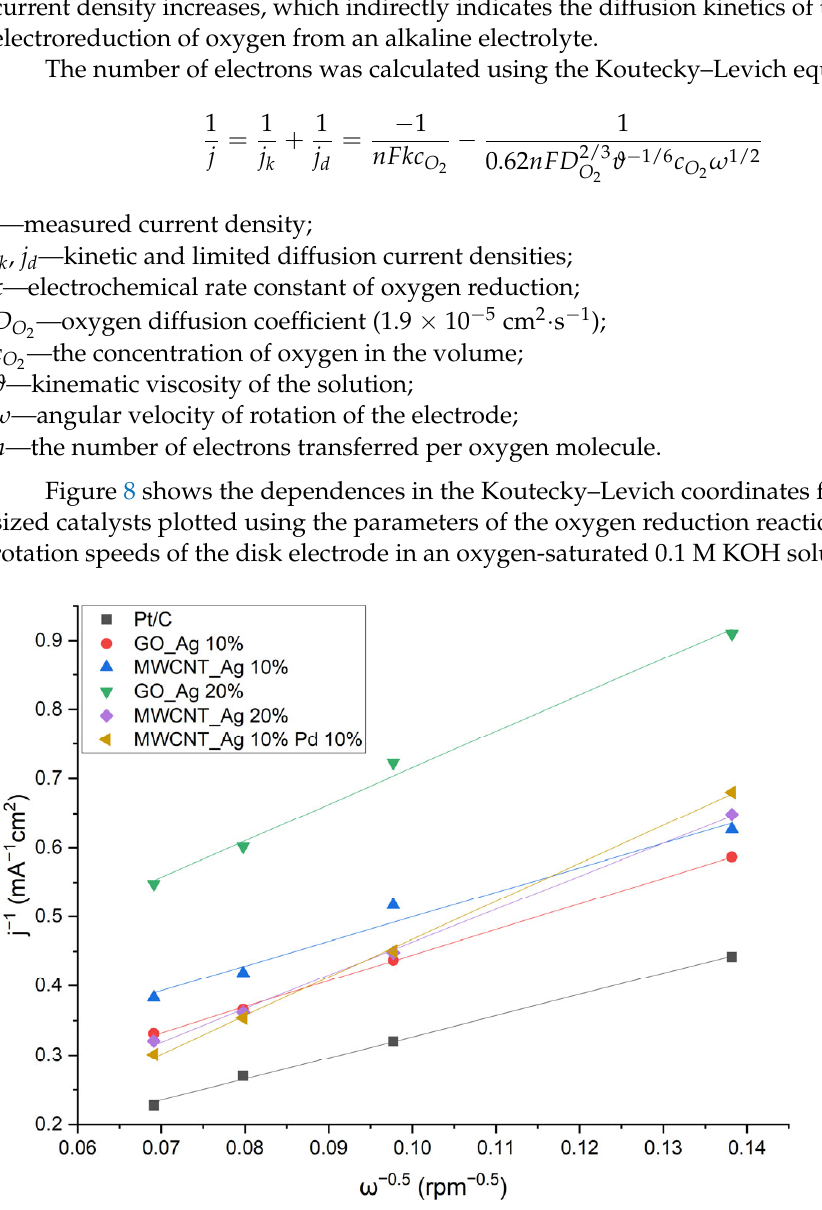
Figure 8. Dependences in coordinates of the Koutecky–Levich equation potential − 0.8 V for the synthesized catalysts.